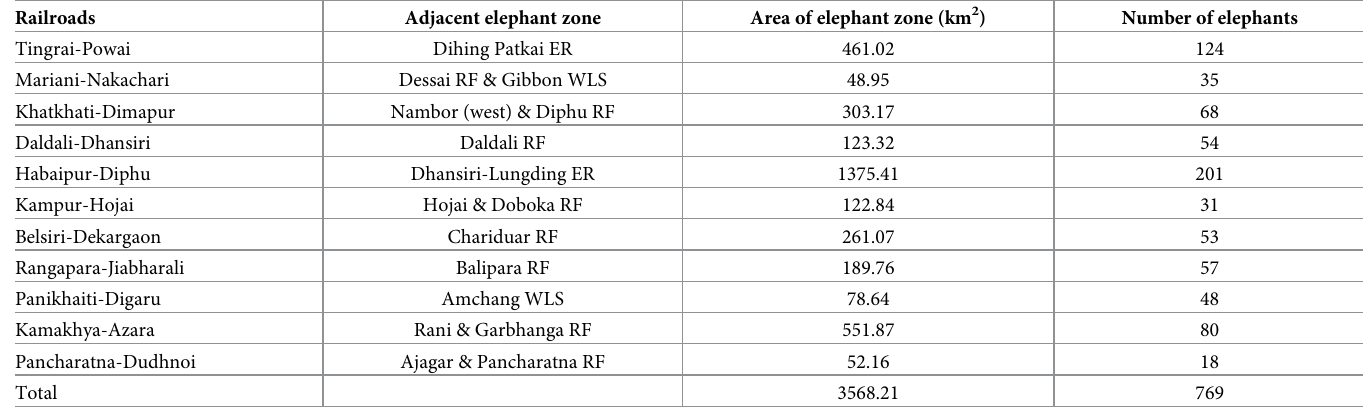
Table 1. Distribution of elephant population in the adjacent elephant zones of the sample